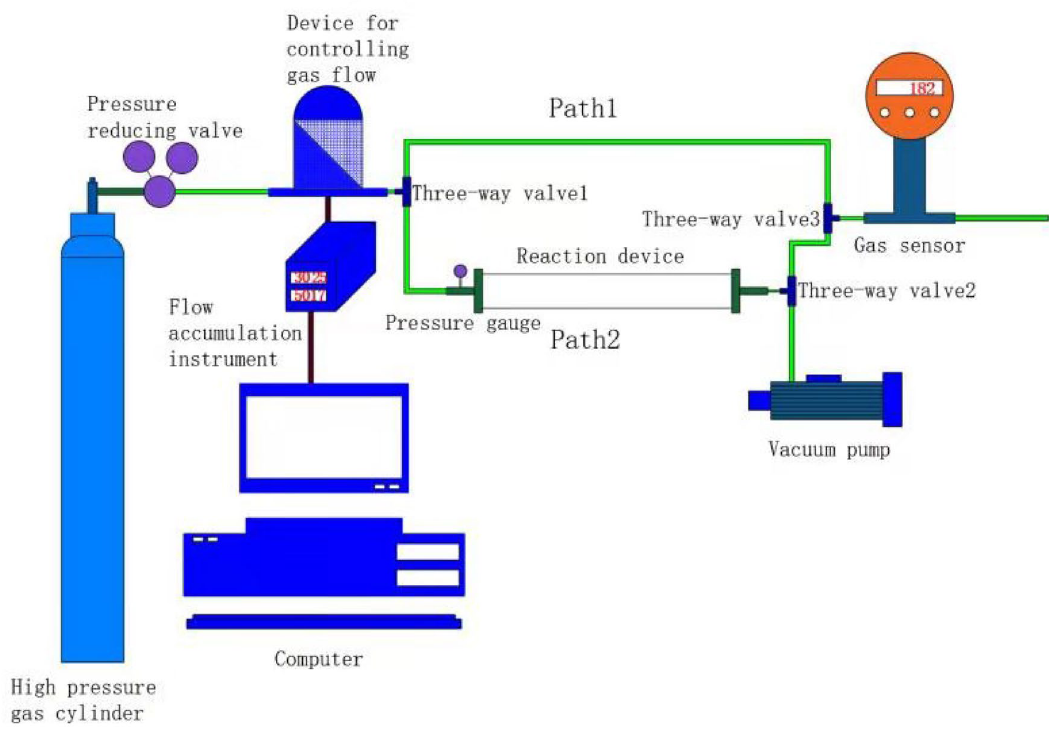
Figure 4. Experimental device